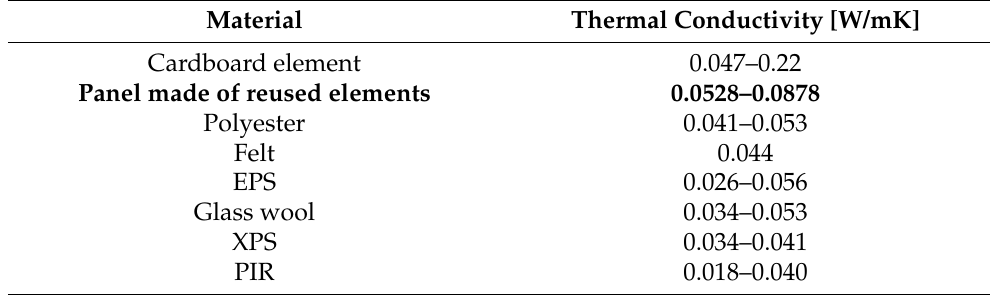
Table 3. Comparison of thermal conductivity of several materials [8]. The properties of the panels proposed in this study are in